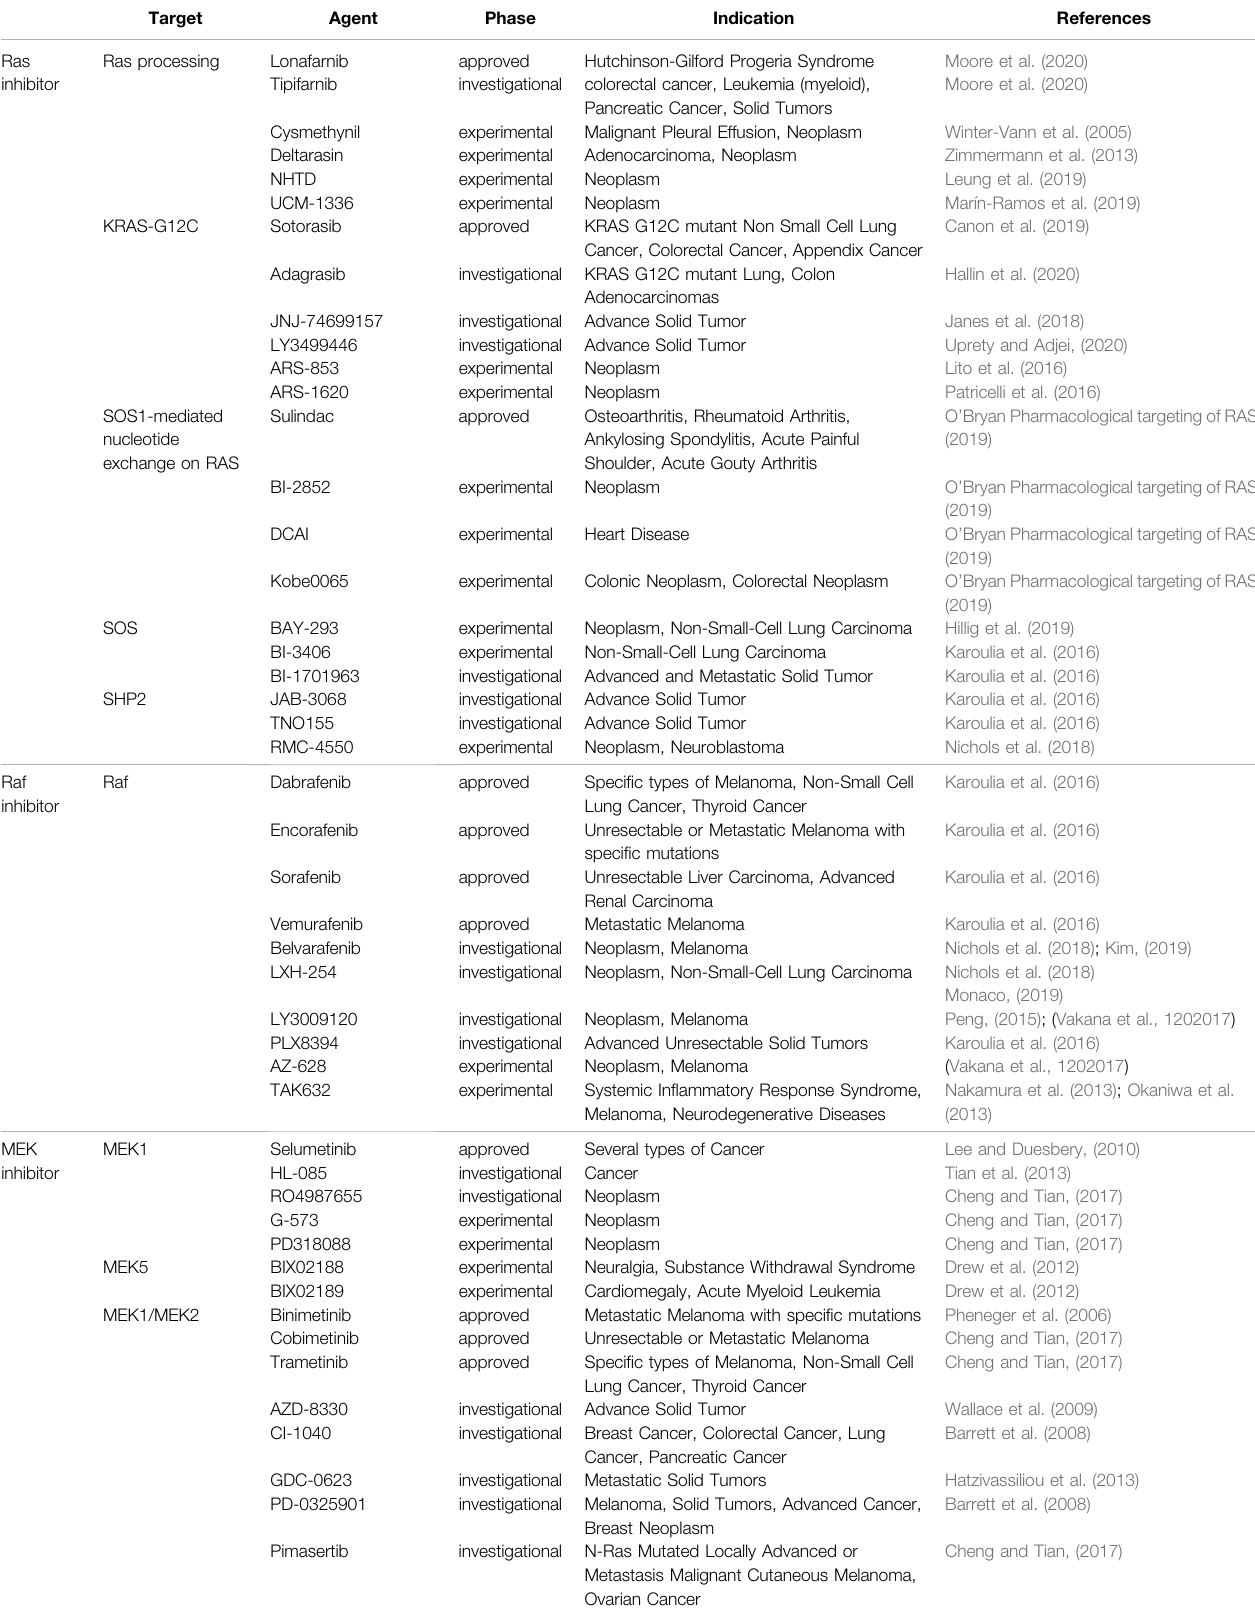
TABLE 5 | Targets in and inhibitor targeting the MAPK